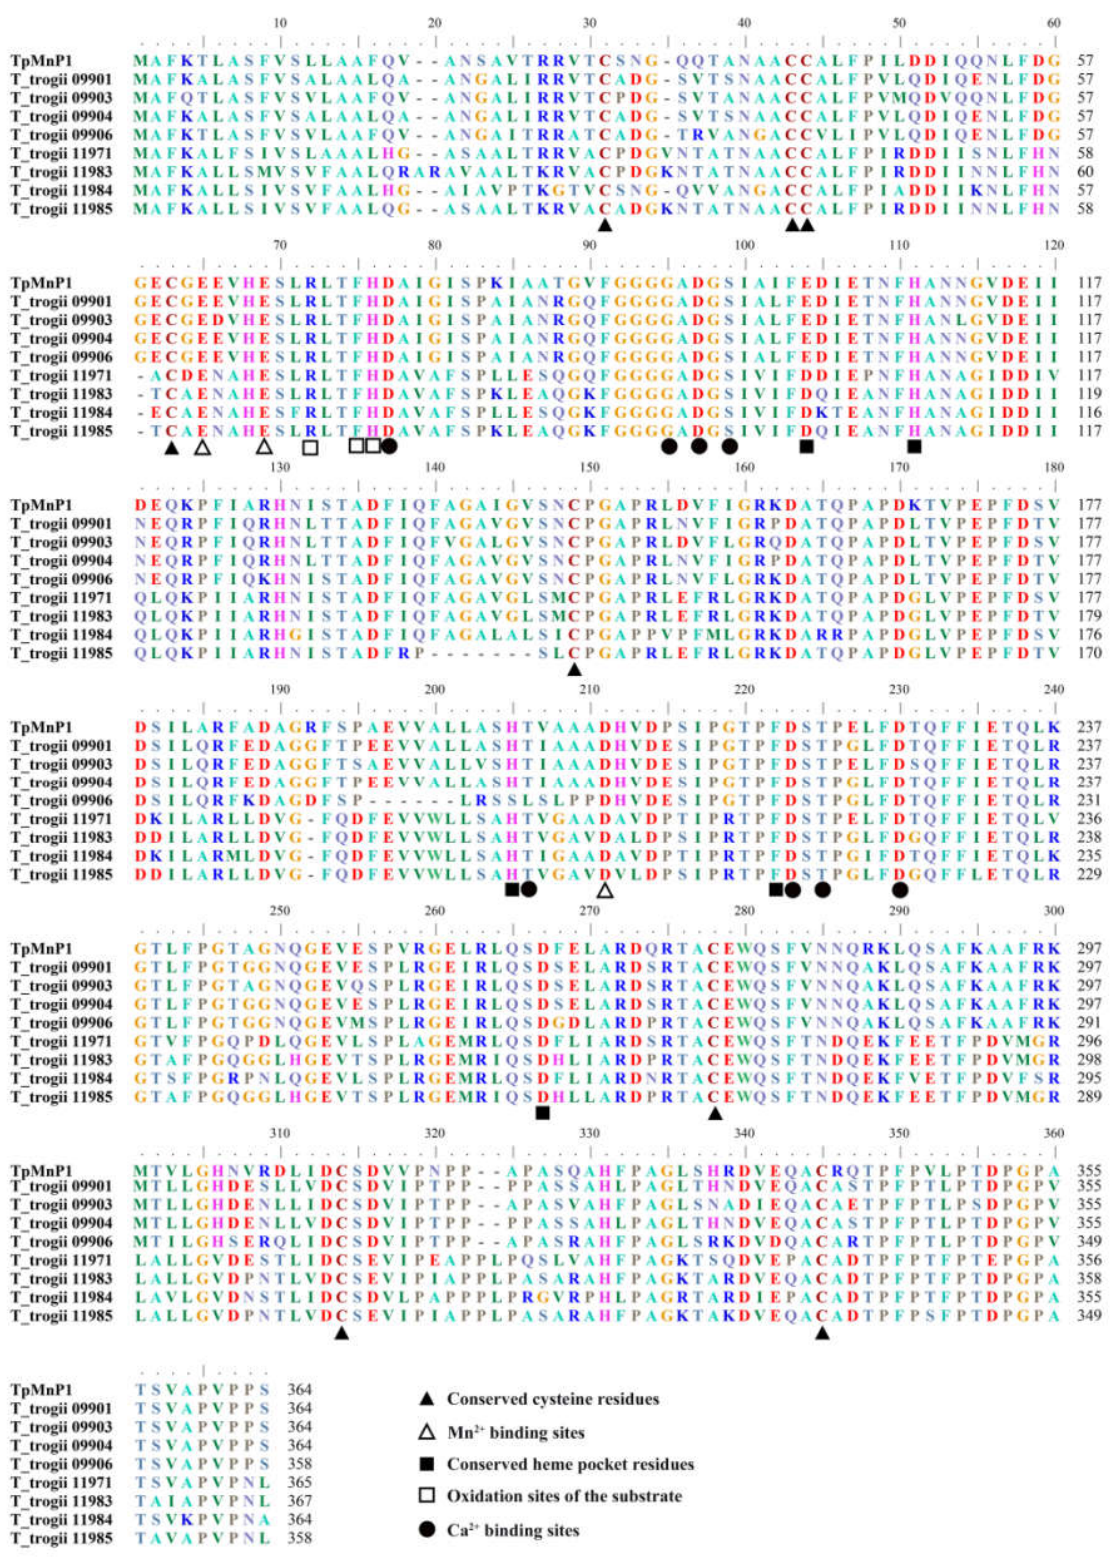
Figure 3. Multiple alignment of amino acid sequences of TtMnP gene family members and the distribution of catalytic and conserved amino acid residues of fungal MnPs.